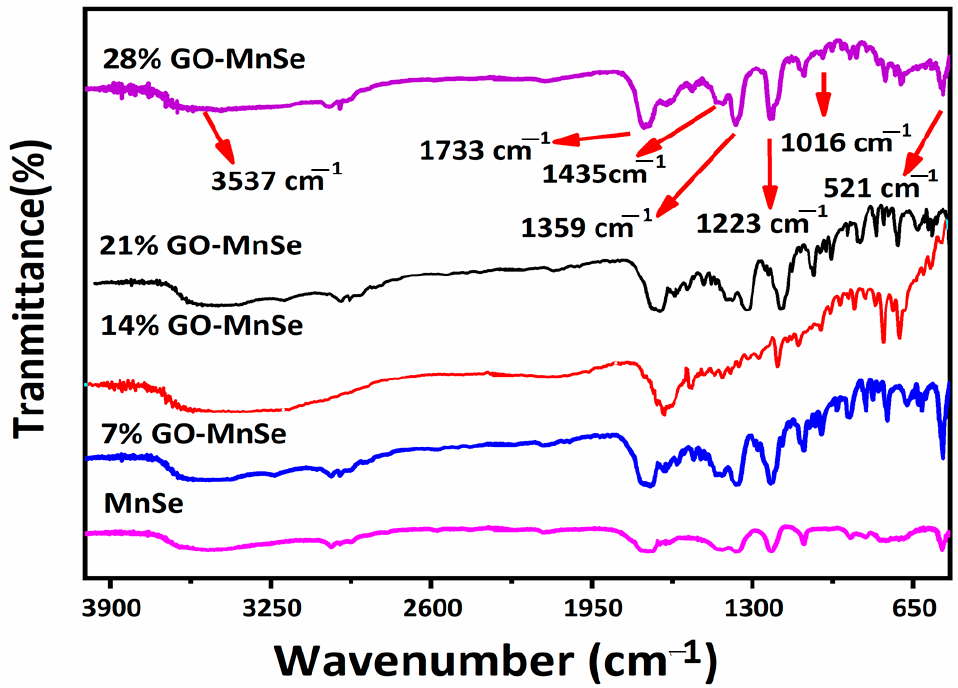
Figure 2. FTIR spectra of MnSe, 7% GO-MnSe, 14% GO-MnS, 21% GO-MnSe, and 28% GO-MnSe. SEM analysis allows high-resolution imaging to evaluate various materials for sur- face corrosion, fractures, contaminants, or flaws. The SEM Tamicrographs of all samples are schematically displayed in Figure 3. Pure GO sample (Figure 3a) indicates wrinkled nanosheets composed of aggregation due to the van der Waals force of attraction, which binds GO sheets together [49]. Additionally, the MnSe sample shows a flake-type mor- phology with different sizes with a dense and closed surface architecture noticed on the MnSe morphology with rough surfaces. According to the XRD investigation, no extra residues were found on the surface, which was also validated from the SEM micrographs, as depicted in Figure 3b, demonstrate the product’s high purity. The effect of different contents of the GO-based MnSe composites, a detailed morphological evaluation, is given in Figure 3c–f. As displayed in Figure 3c, the 7% GO-MnSe composite showed highly aggregated GO sheets on the surface of MnSe. Additionally, the 14 %GO-MnSe composite showed a more uniform distribution of GO on the surface of MnSe than the previous sam- ple (Figure 3d), signaling better photocatalytic performance. In addition, 14% GO-MnSe composite showed the homogenous distribution of GO and eventually covered the MnSe surface (Figure 3e). The GO is seen to be well distributed on the whole surface of the composite material. At the same time, the MnSe arranges in a loose surface architecture, offering highly express roadways and better charge carrier migration. When the GO con- tents are further increased to 28% (28% GO-MnSe composite), the morphology of the MnSe product seems to be particles hidden with GO sheets.